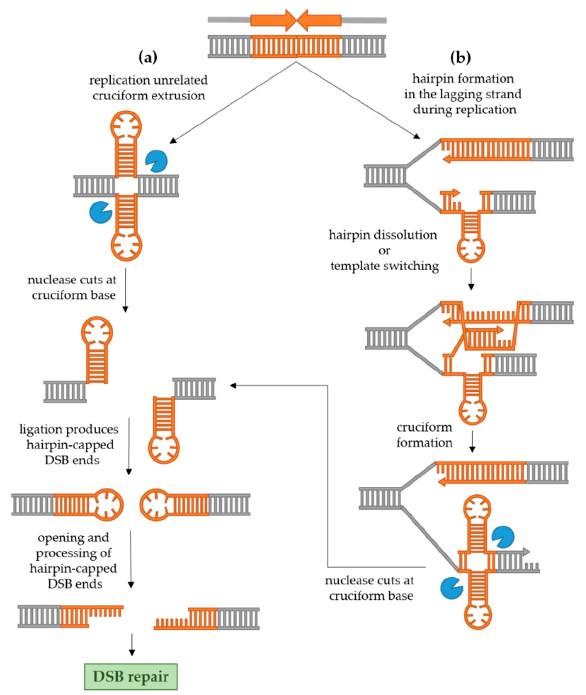
Figure 2. Mechanisms of palindrome recombinogenicity. ( a ) Independently from DNA replication, a cruciform structure can extrude in the dsDNA. The cruciform is cut by a structure-specific endo- nuclease, after which ligation produces closed hairpin-capped double-strand break (DSB) ends. Such ends must be opened and processed into conventional DSB ends which can undergo repair. ( b ) During replication, especially if the replication machinery is impaired, a hairpin can form in the ssDNA of the lagging strand, causing replication stalling. The hairpin can be dissolved by hel- icase, or, alternatively, template switching allows synthesis of the nascent strand using the leading strand as a template. This produces a nascent complementary strand containing a hairpin as well, across the hairpin in the lagging strand. Again, the resulting cruciform can be cut by a structure- specific endonuclease, followed by formation of hairpin-capped DSB ends, their processing and subsequent DSB